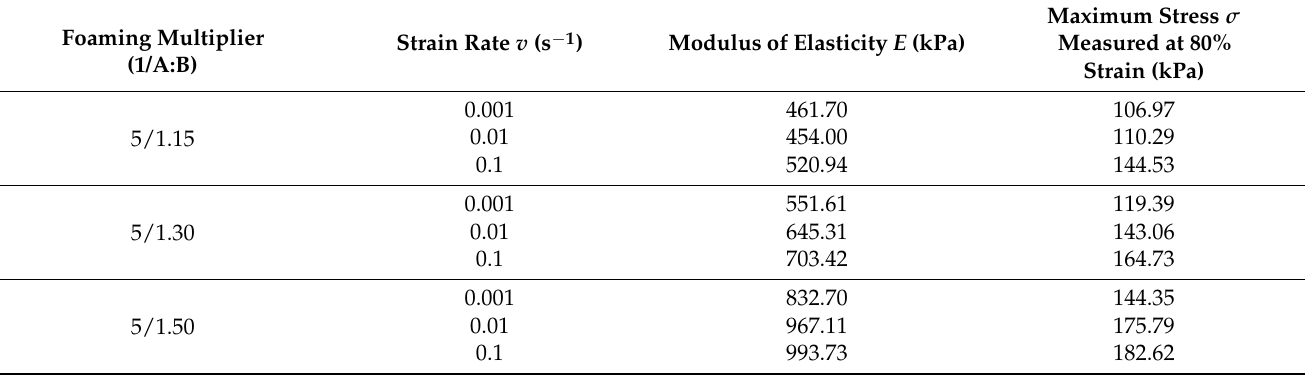
Table 1. Statistical data of different foams at three strain